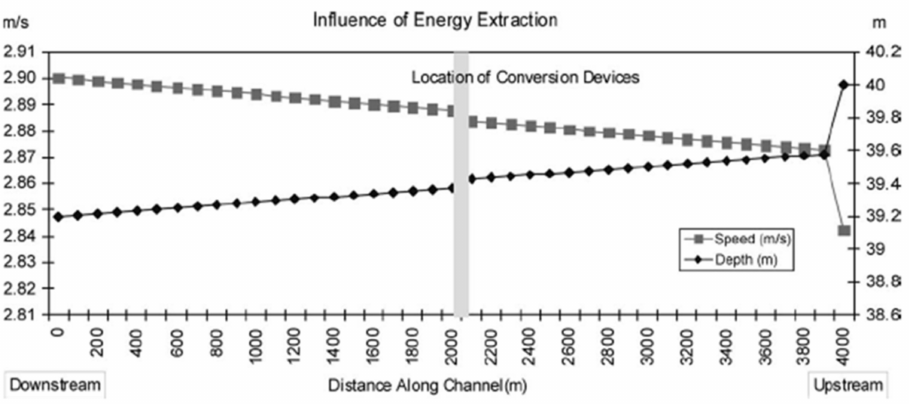
Figure 4. Influence of artificial energy extraction on speed and depth of flow